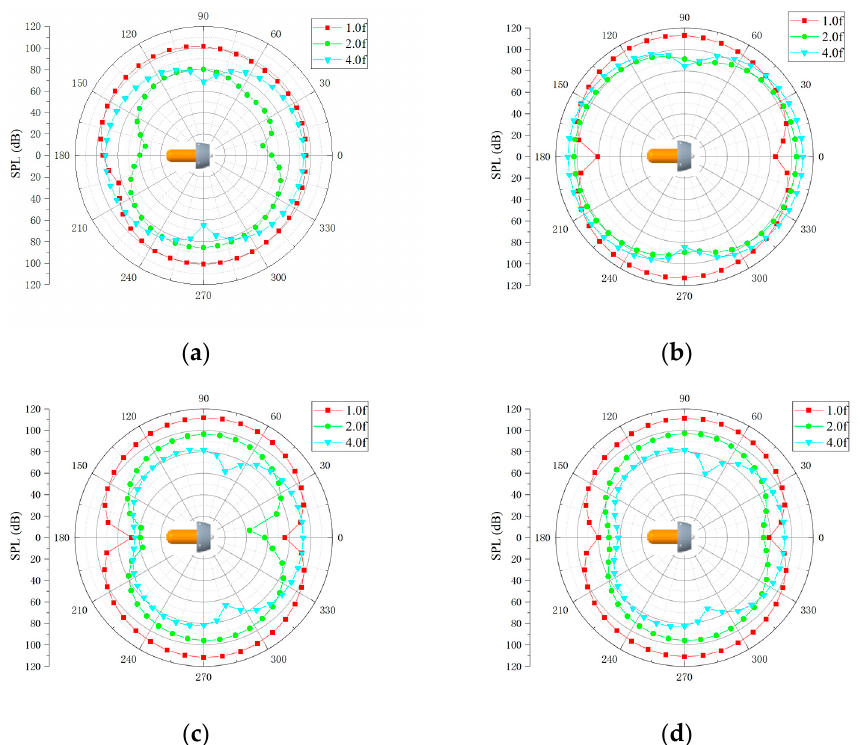
Figure 15. Directivity diagram of sound pressure level at different navigational speeds. ( a ) 0 m/s; ( b ) 0.37 m/s; ( c ) 1.54 m/s; ( d ) 2.057 m/s.